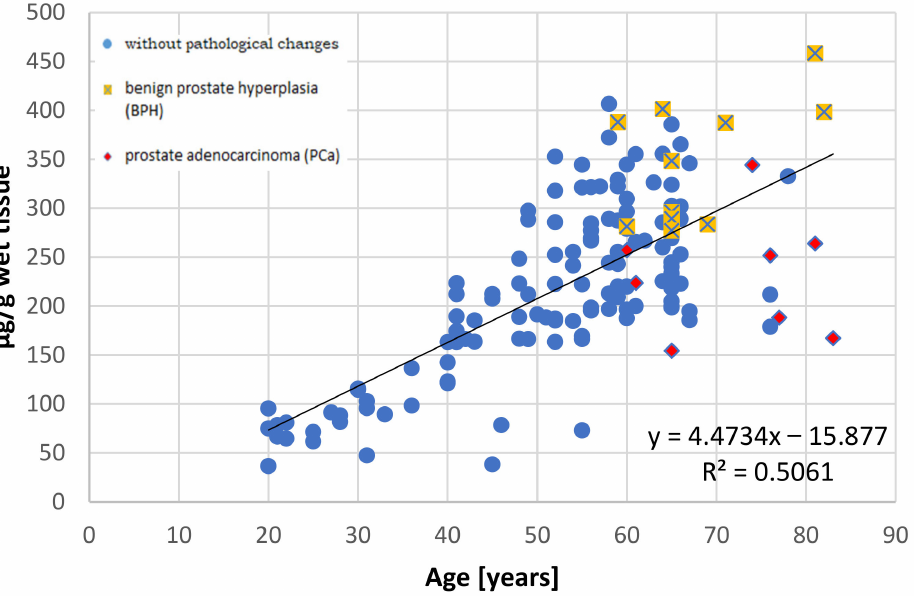
Figure 2. The relationship between zinc concentration ( µ g/g wet tissue) and age (years) in the central part of the human prostate with regard to histopathological